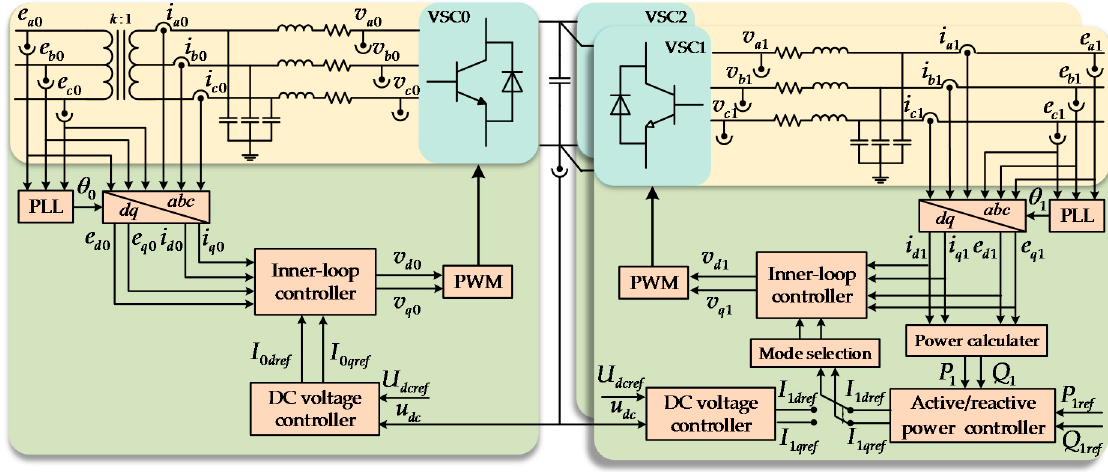
Figure 5. Control schematic of the VSCs.